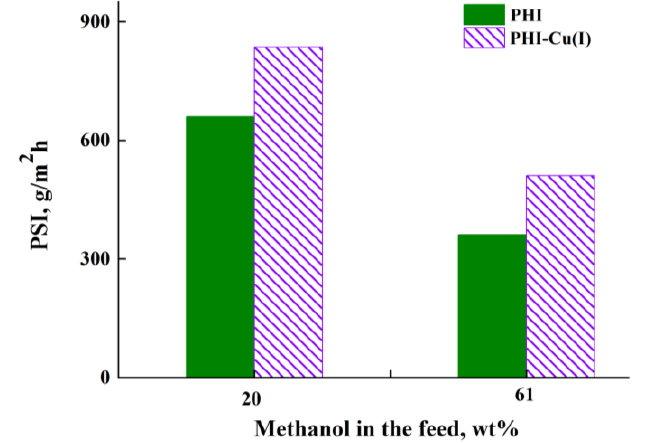
Figure 11. Pervaporation separation index ( PSI ) vs. methanol concentration in the feed for pervapo- ration through the (1, 1′ ) PHI and (2, 2′ ) PHI- Сu(I) membranes, 40 °C.